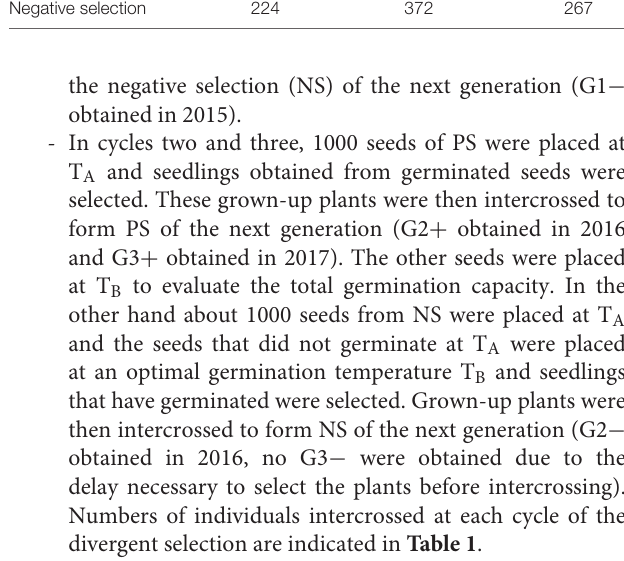
Frontiers in Plant Science |